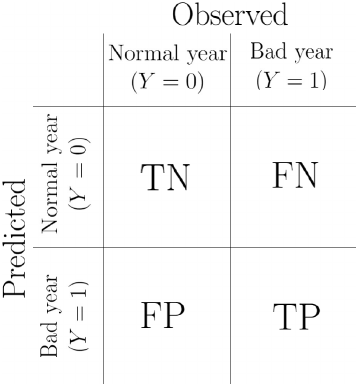
Figure 4. Confusion matrix for classification of observed and pre- dicted normal and bad